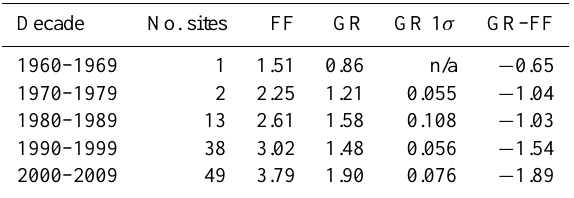
Table 2. Global decadal mean growth rates (GR) and the corre- sponding growth rate due to fossil fuel combustion (FF) and natural sources (GR–FF). Units are ppmyr − 1